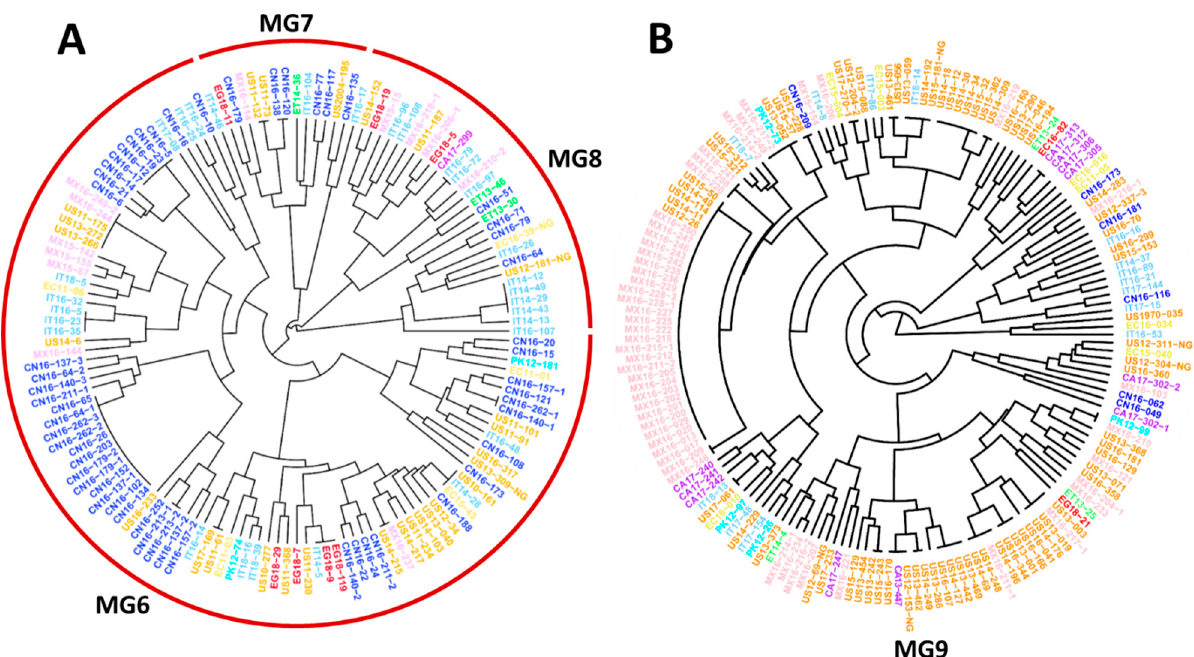
Figure 4. Dendrograms of major molecular groups (MGs) of Puccinia striiformis f. sp. tritici showing genetically related isolates from different countries. ( A ) Dendrogram of isolates in MG6, MG7, and MG8. ( B ) Dendrogram of isolates in MG9. These dendrograms were constructed based on dissimilarities assessed with 14 simple sequence repeat markers (SSR) using hierarchical cluster analysis.